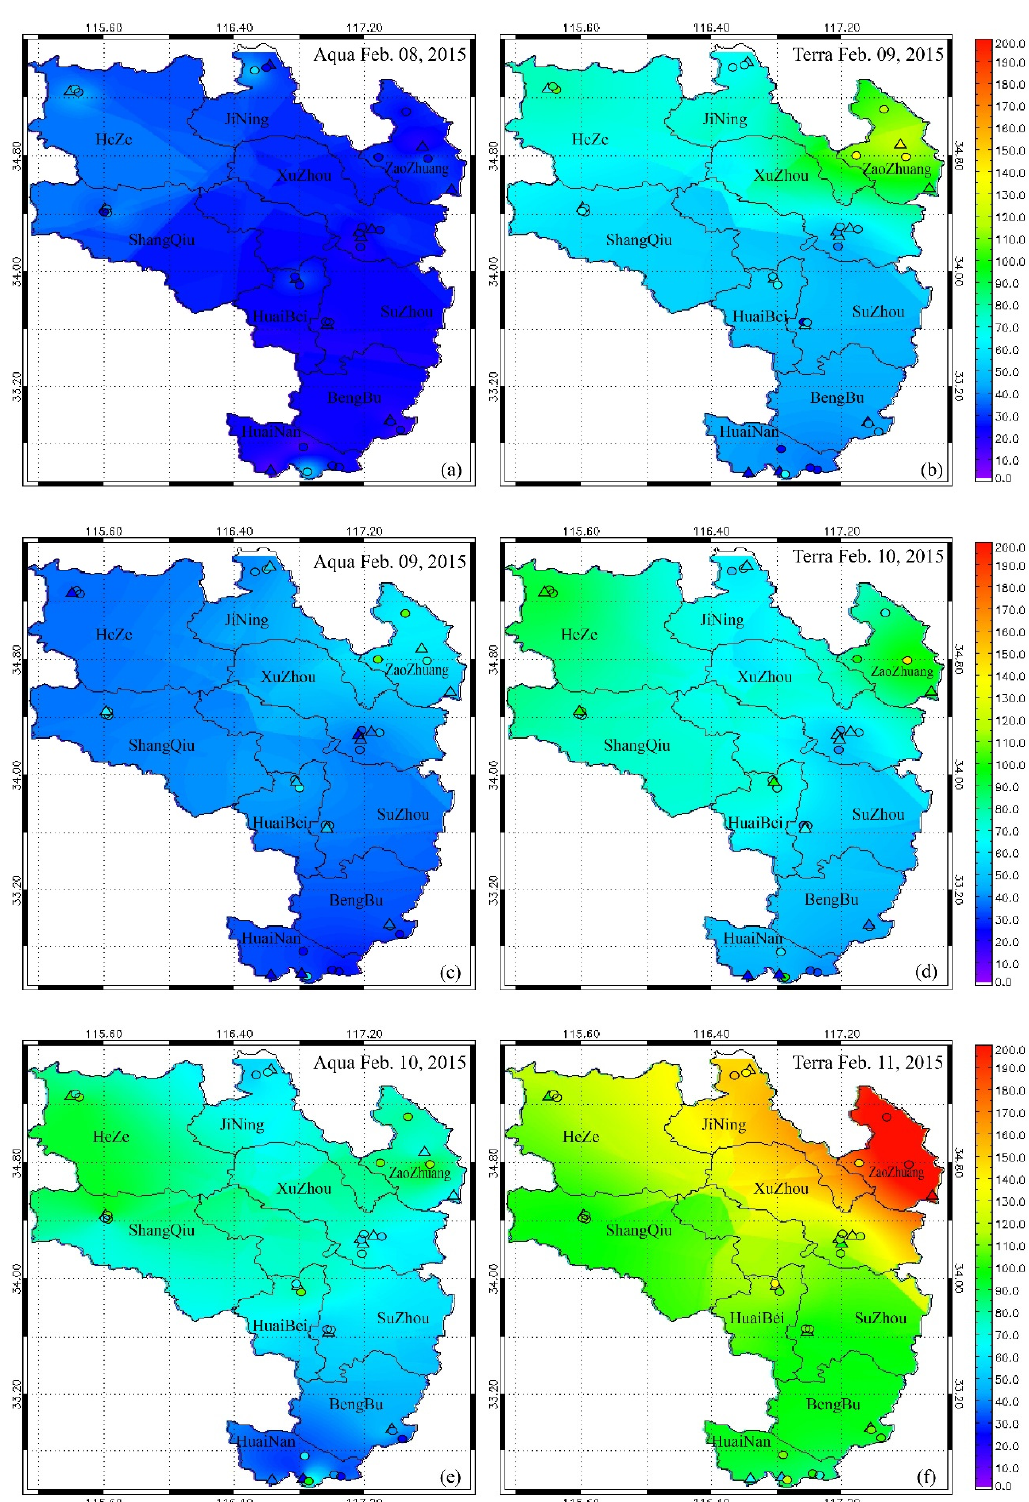
Figure 11. Spatial distribution of ground PM 2.5 measurements over the study region during a haze formation process from the afternoon of 8 February 2015 to the morning of 11 February 2015, referring to the local passing moment of satellites Terra and Aqua (( a ) Aqua 8 February 2015; ( b ) Terra 9 February 2015; ( c ) Aqua 9 February 2015; ( d ) Terra 10 February 2015; ( e ) Aqua 10 February 2015; and ( f ) Terra 11 February 2015). In situ measurements at training stations (circles) and validation (triangles) stations are also shown in the figures.